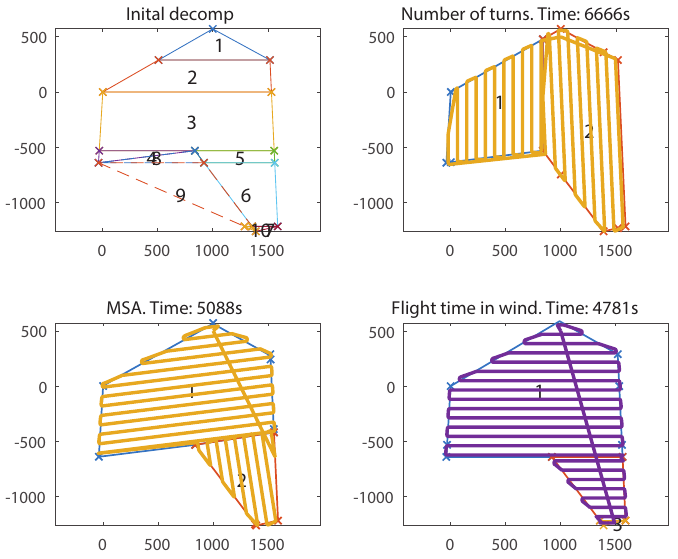
Figure 23. Final decompositions and flight paths generated from the example survey field in Figure 19 in a strong northerly 8 m/s wind, for FTIW, MSA and NT.